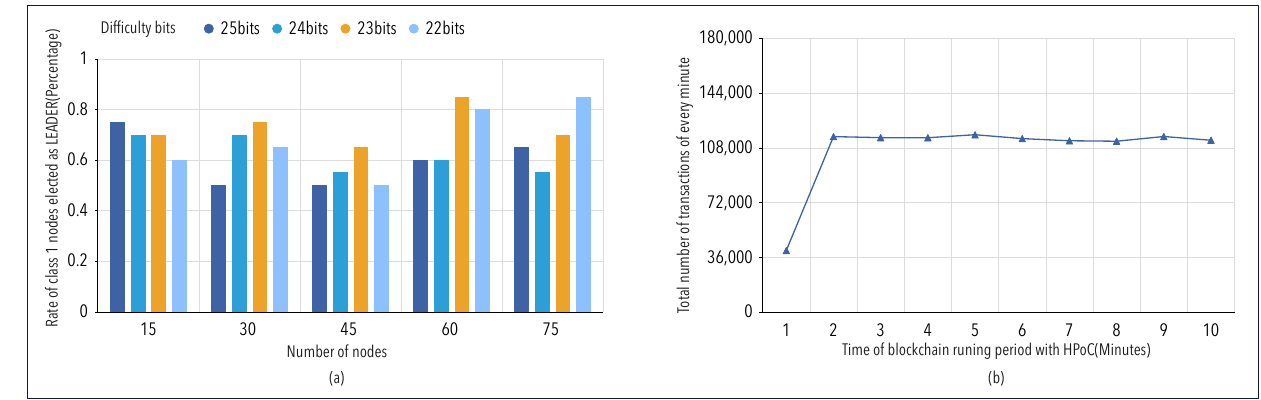
Figure 9. Simulation results: ( a ) probability of Class 1 nodes elected as LEADER; ( b ) tendency of transactions of running blockchain with HPoC in ten